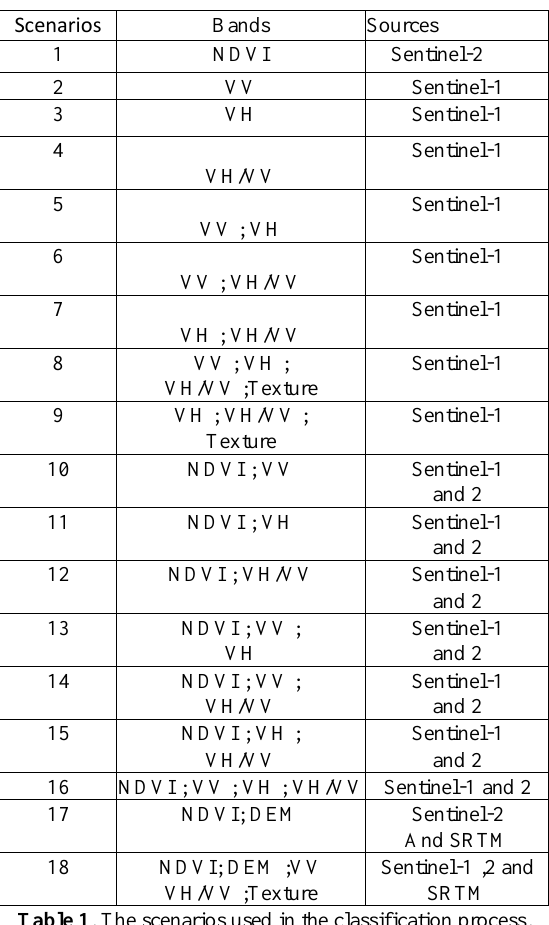
Table 1 . The scenarios used in the classification